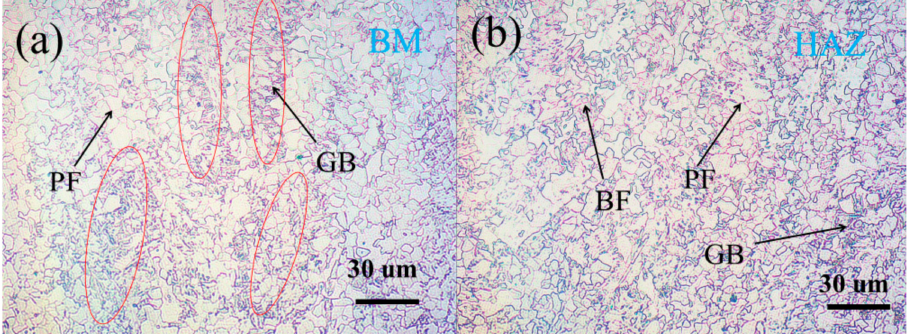
Figure 2. Microstructure of the X80 steel observed by optical microscope (OM) in the rolling-transverse direction: ( a ) the base metal (BM)and ( b ) heat-a ff ected zone